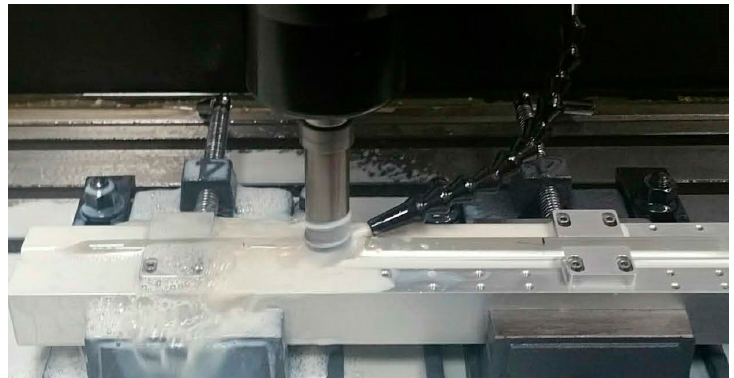
Figure 3. Milling of the preform on a customized milling stage with Standard Series 10 Rotary Knee mill from Sonic-Mill.